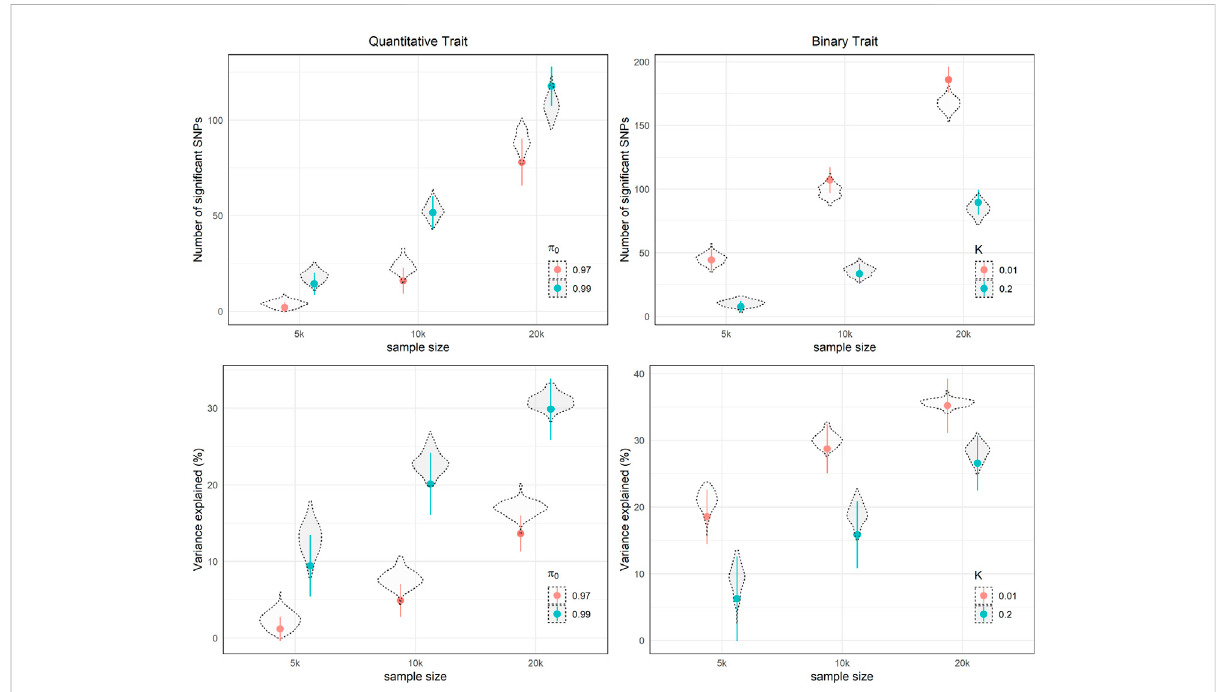
FIGURE 3 Theoretical expectednumberofindependentsigni fi cantSNPsandvarianceexplained